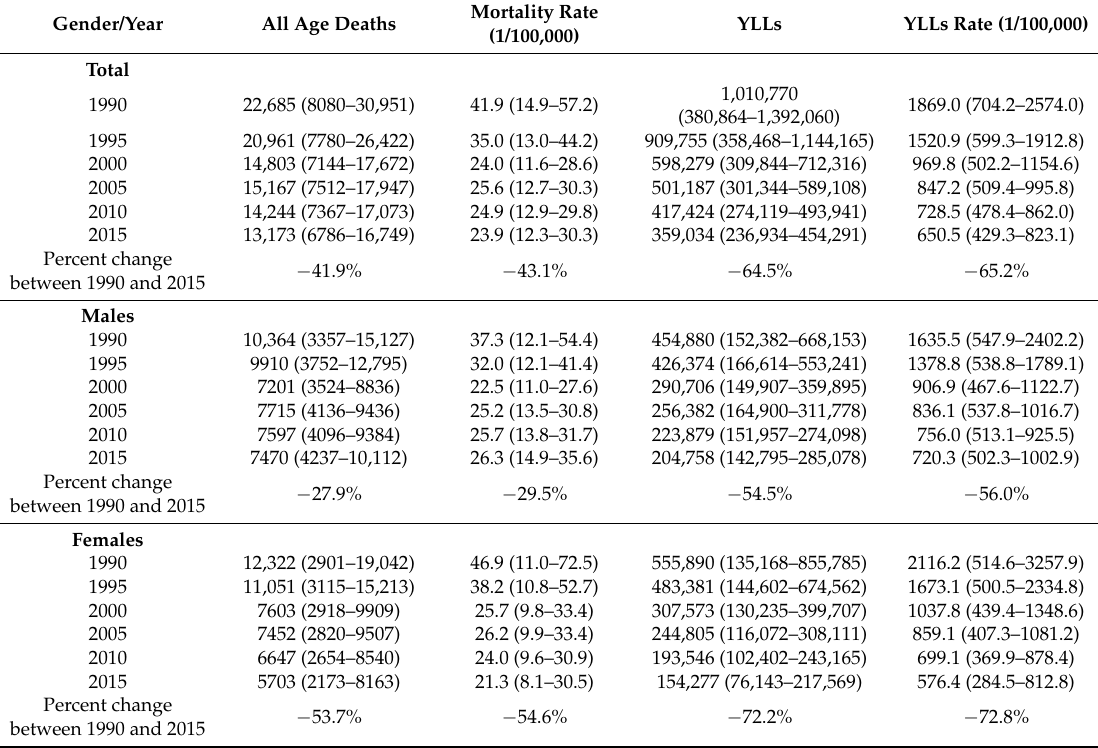
Table 1. Fatal outcome of self-harm in Hubei,